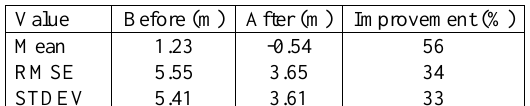
Table 3. Height difference values for area #2 before and after morphing, with no triangle threshold.